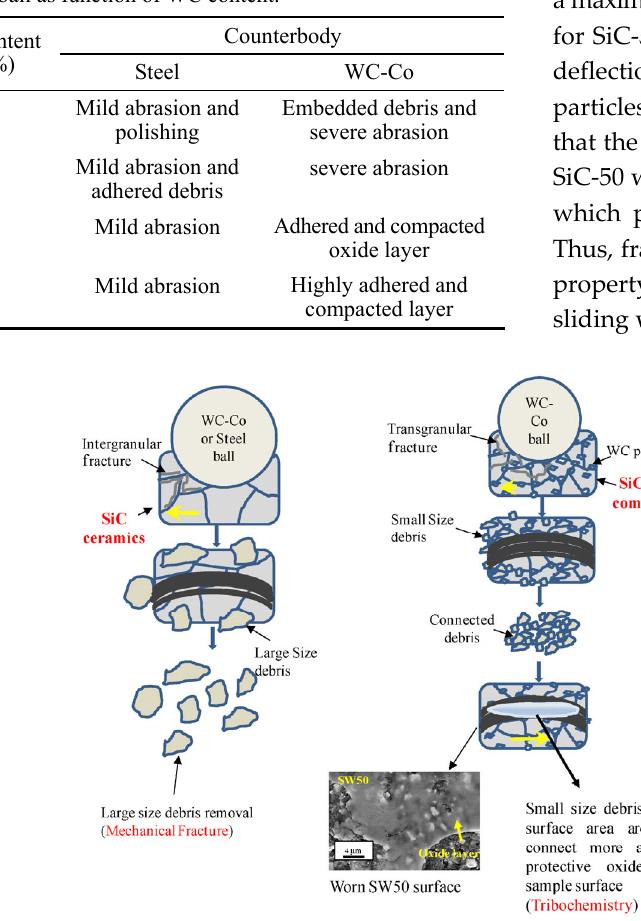
Fig. 14 Schematic illustration of wear mechanism for SiC ceramics and SiC-WC ceramics when slid against WC-Co or steel